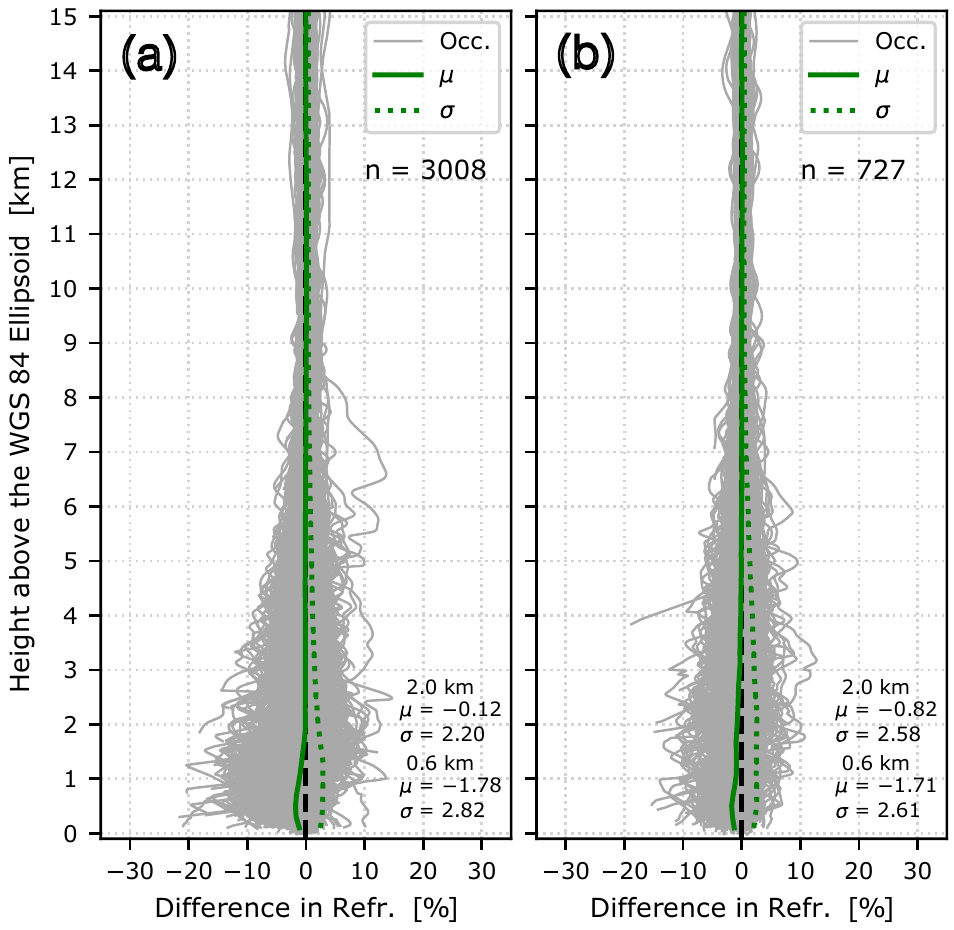
Figure 14. Statistical comparison between the operational dataset occultations (green lines) during AR Recon that sampled ( a ) outside and ( b ) inside an atmospheric river and the ERA5 reanalysis product. Notation the same as Figure